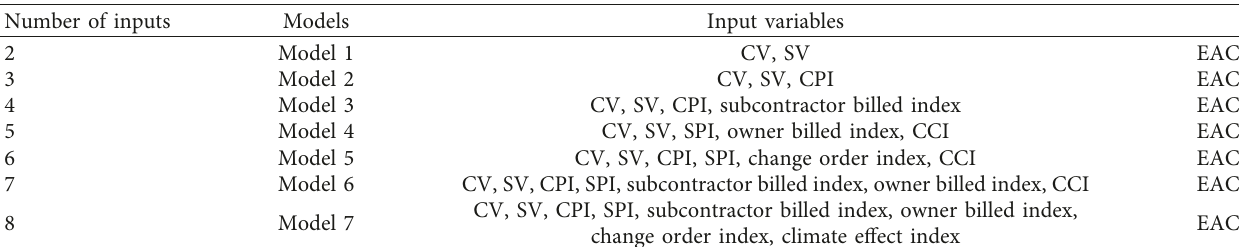
Table 3: The input combination attributes used to determine the value of the EAC using GA-DNN model.